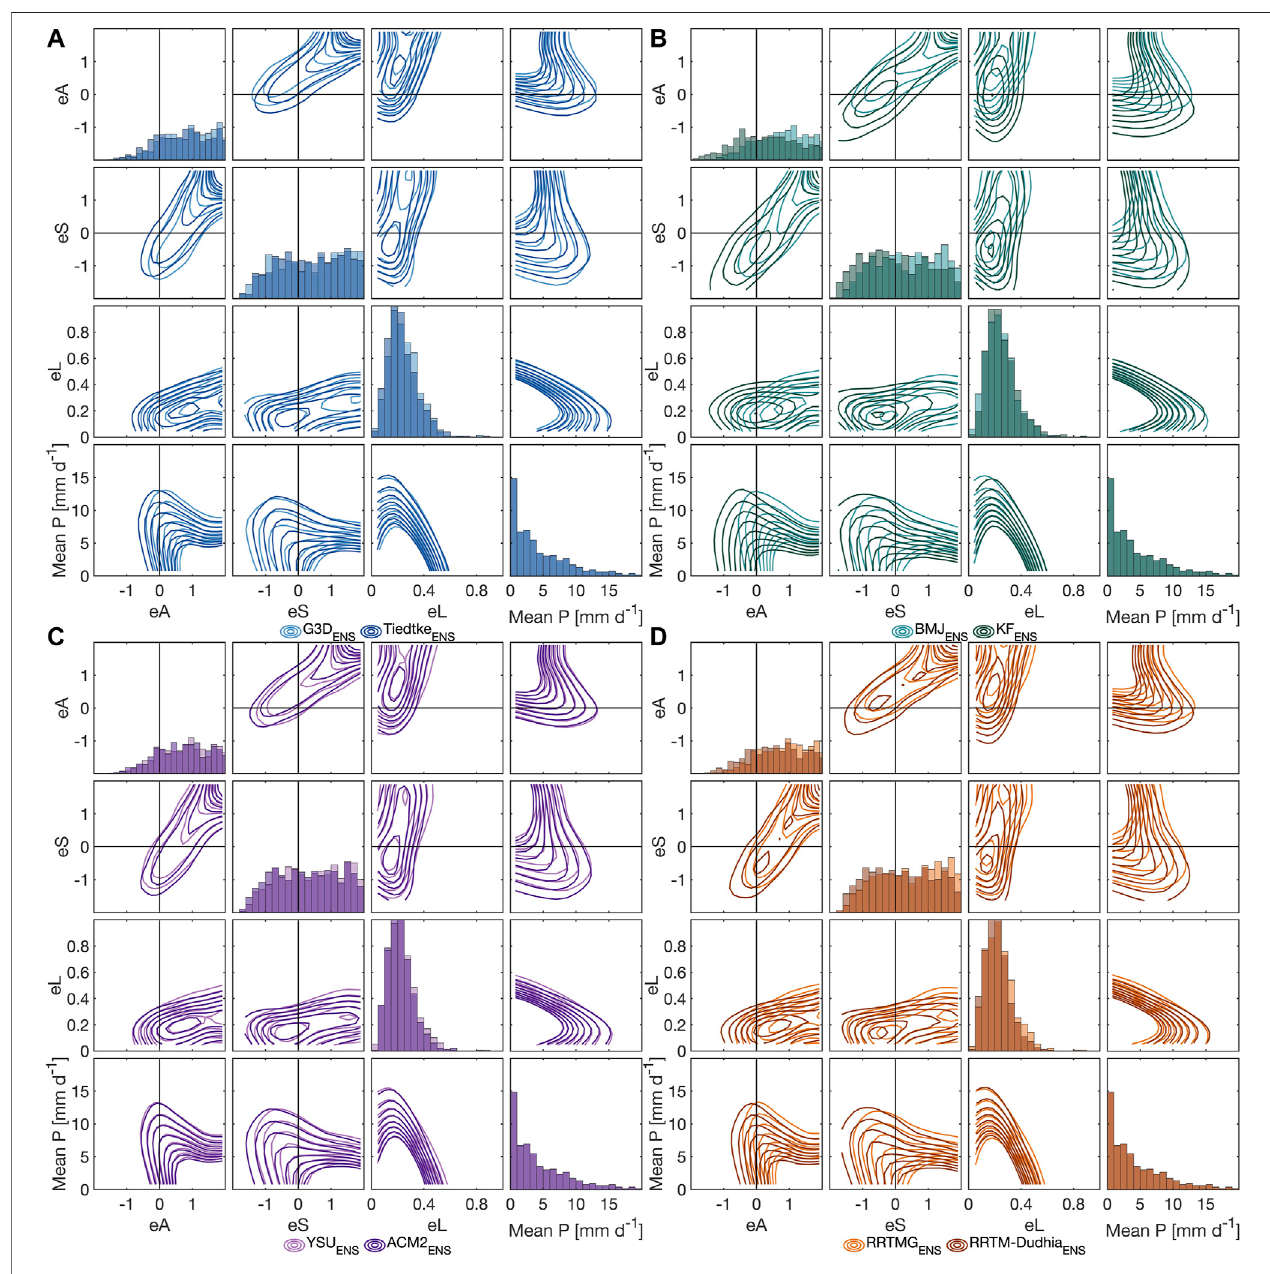
FIGURE 12 | As Figure 10 , but for